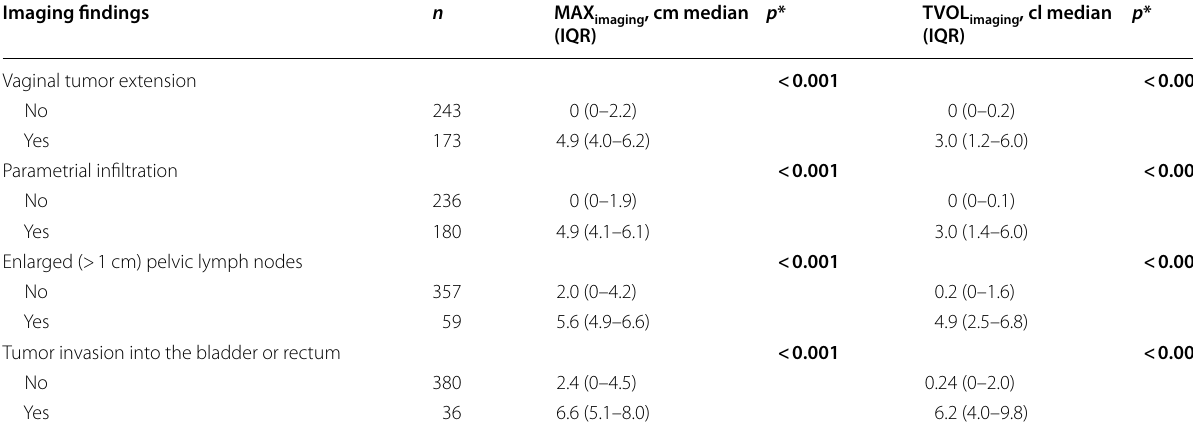
IQR, Interquartile